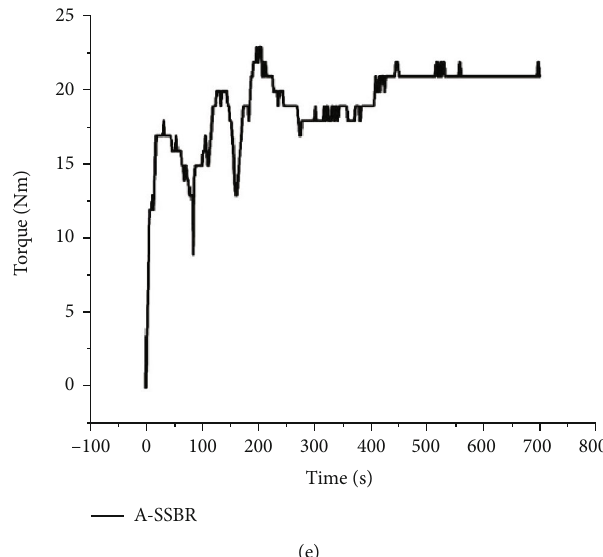
Figure 3: Graphs of torque changes over time for di ff erent mixtures: (a) S-SBR, (b) E-SBR, (c) Si69-SSBR, (d) T-SSBR, and (e)